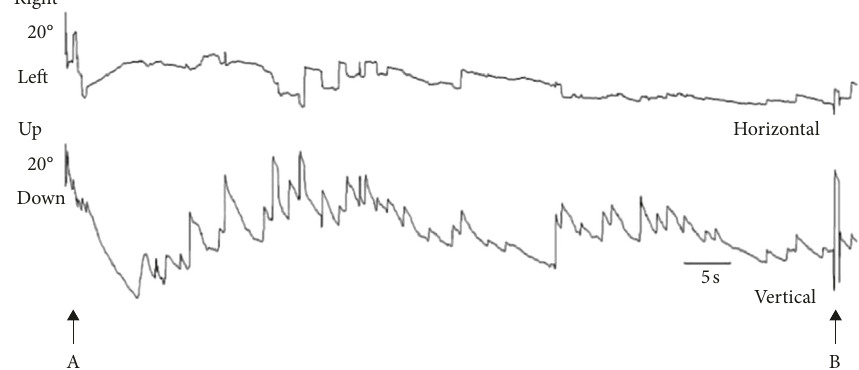
Figure 1: Video-oculographic recording of upbeat nystagmus (maximum slow phase velocity about 9.0 ° /s) in a straight supine position during the head roll test. A: the moment of the straight supine position and B: the moment of turning the head position from straight to the left ear-down supine